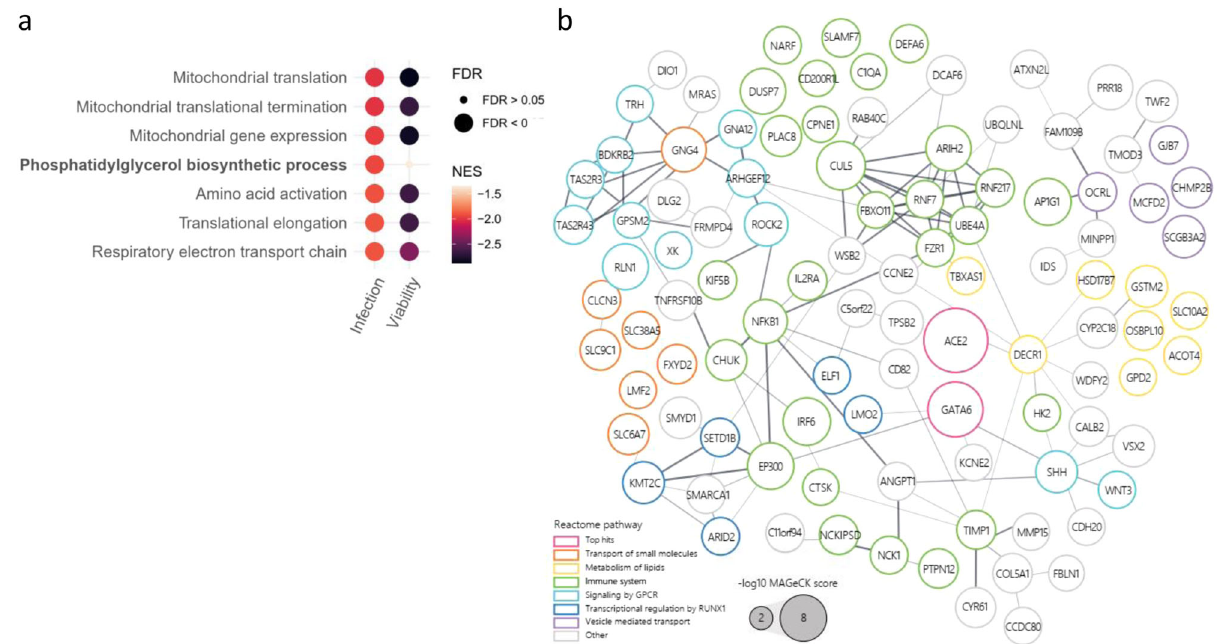
Fig. 2 Gene set enrichment and interaction networks analysis identify functional pathways important for wild-type SARS-CoV-2 and variants of concern infection. a Gene set enrichment analysis (GSEA) was performed by analysis of the directed scores of all genes from the WT-SARS-CoV-2 and VOCs screens combined (infection), and for the uninfected cell viability screen (viability). Results from the infection screens were fi ltered to get signi fi cantly enriched pathways with false discovery rate (FDR) of less than 0.01. The enrichment of each of these pathways in each screen is represented as bubbles colored by Normalized enrichment score (NES) and sized by signi fi cance levels. b Protein – protein interaction network for top 200 enriched hits from all strain screens combined based on STRING analysis. Edge thickness represents interaction score. Nodes are colored by selected REACTOME pathways and sized according to log10 transformed screen enrichment score. Source data are provided as a Source Data fi